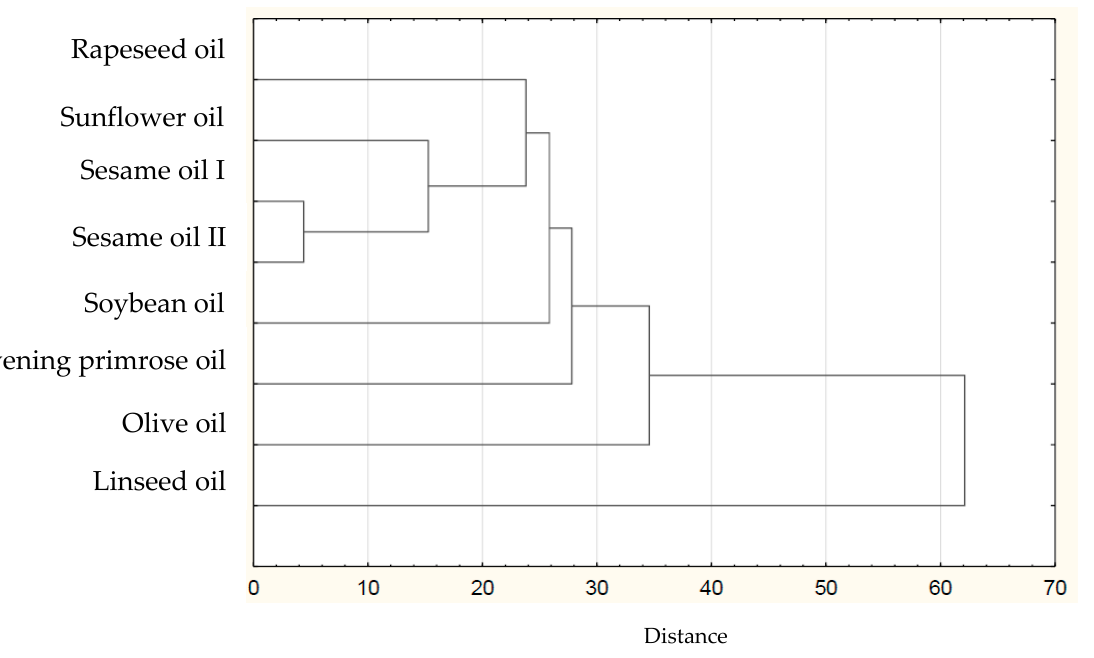
Figure 1. Hierarchical cluster graph of the commonly used oils. Sesame oil I - source is ref [17]. Sesame oil II - source is ref [19].